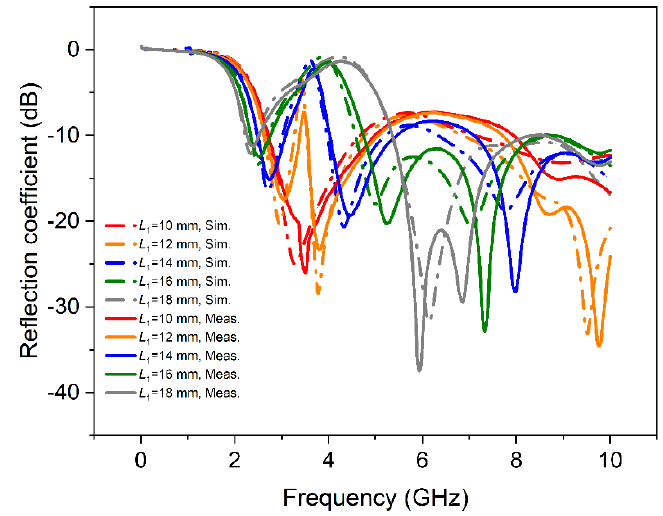
Figure 4. The reflection coefficient of the antenna (the initial condition: L 1 = L 2 = 10 mm).